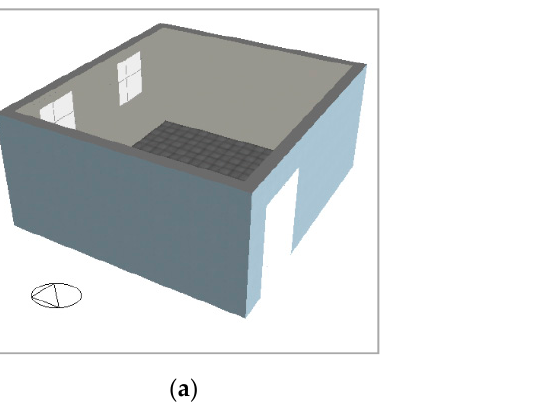
Figure 4. ( a ) Three-dimensional axonometric view for the classroom showing the two windows and door openings and ( b ) external elevation showing the size and position of the windows.